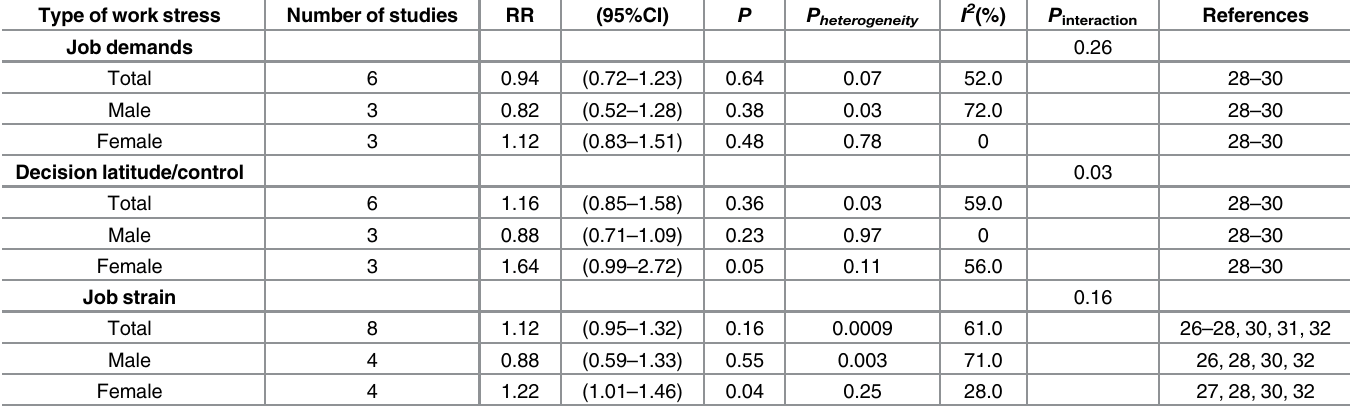
Table 2. Subgroup analyses relating work stress to type 2 diabetes by